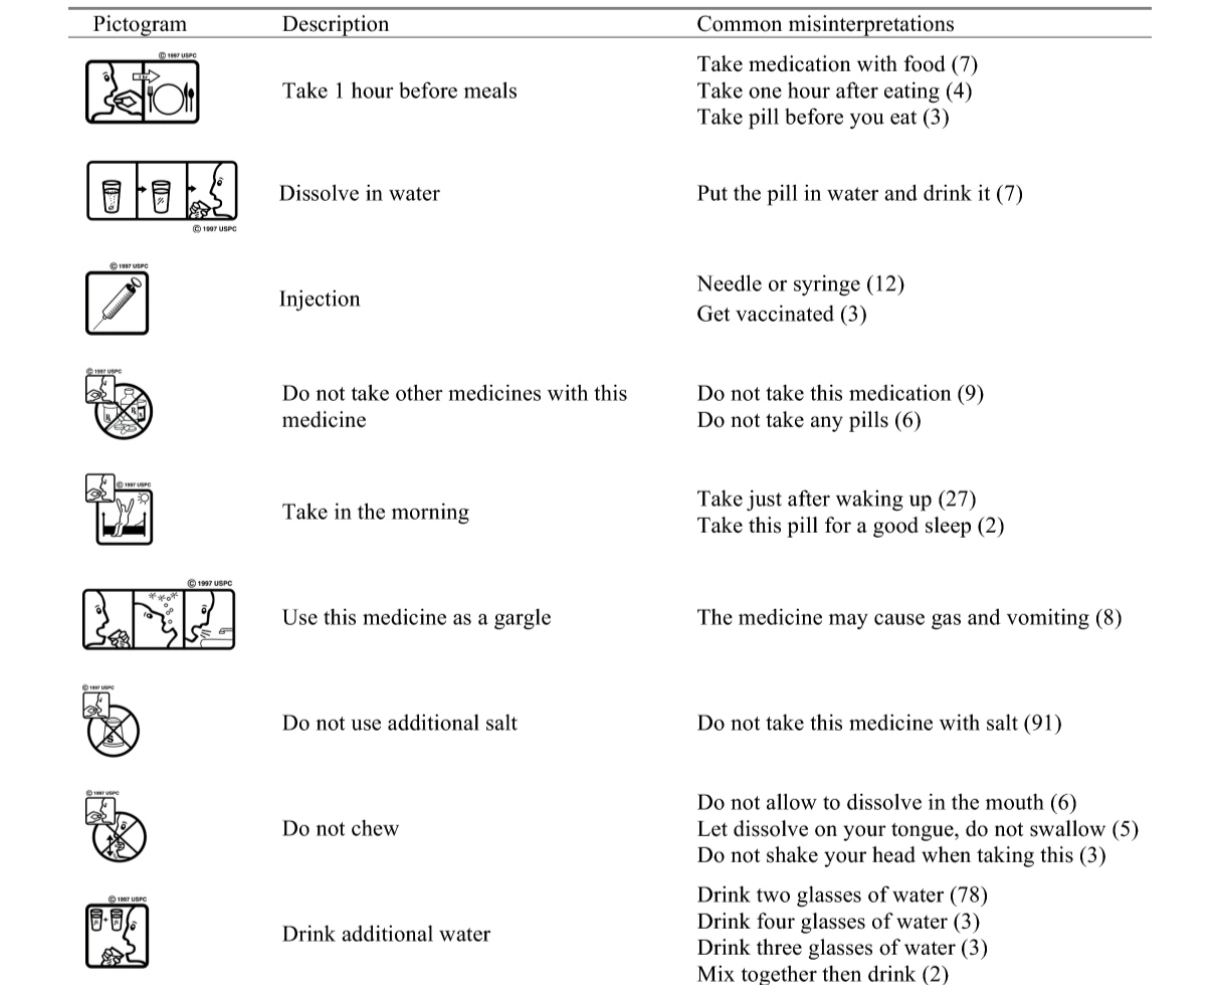
Figure 7. Common